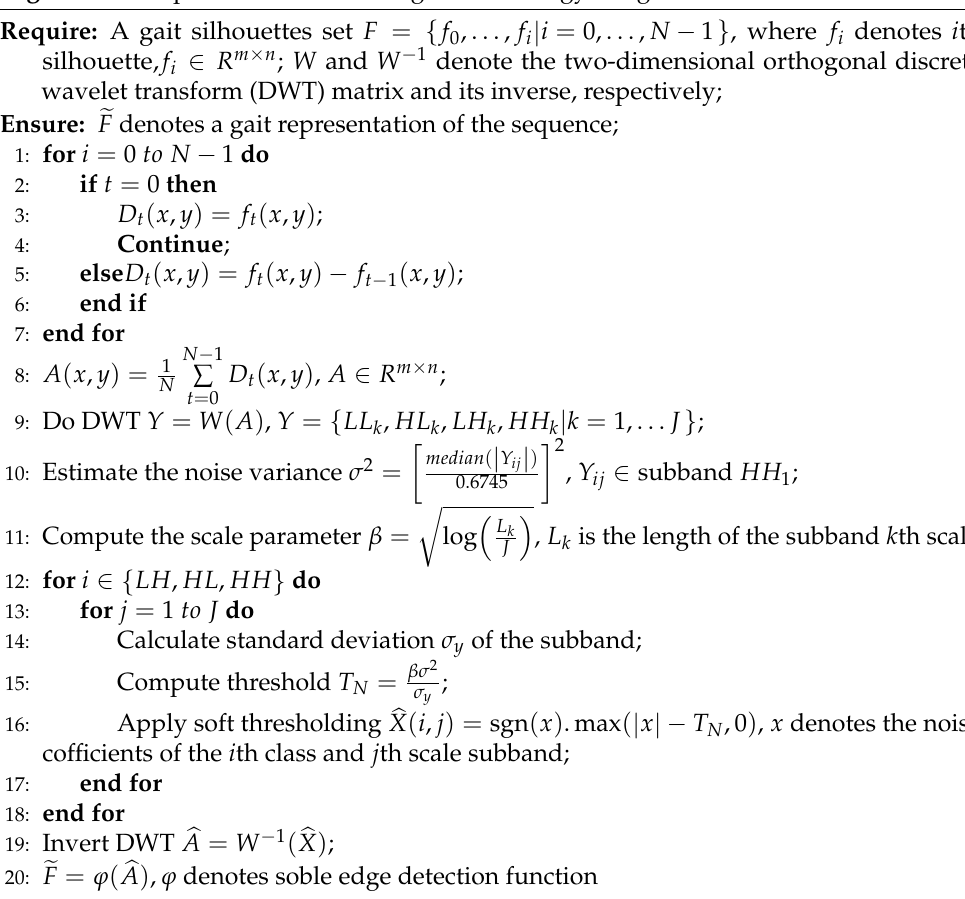
Algorithm 1 Improved-Sobel-Masking Active Energy